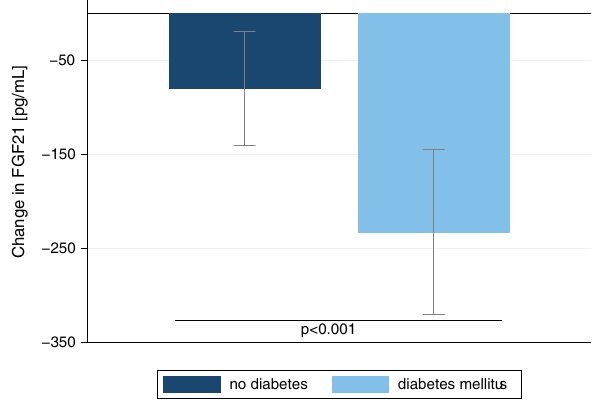
Figure 3. Effects of dexamethasone on serum FGF21 levels. Bar graph with mean absolute differences in FGF21 levels (± 95% confidence interval) between the baseline value and measurements at day 1 in patients without (blue) and with diabetes mellitus (light blue). P-value determined by linear regression stratified by the history of diabetes mellitus included as interaction